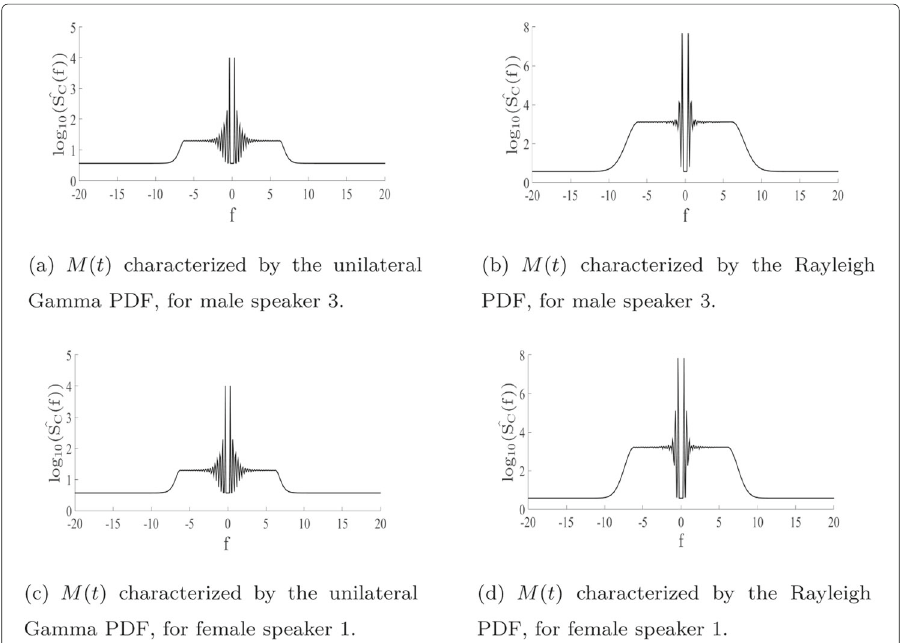
Fig. 7 PSD estimates, log 10 ( ˆ S C ( f )) ( db ) , as a function of f ( × π rad/s ) , of an impulse train modulated in position by a random signal M ( t ) characterized by two PDFs for male and female speakers